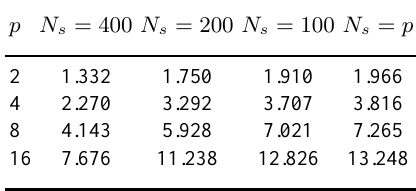
Table 2. Speed-up of the parallel algorithm with data